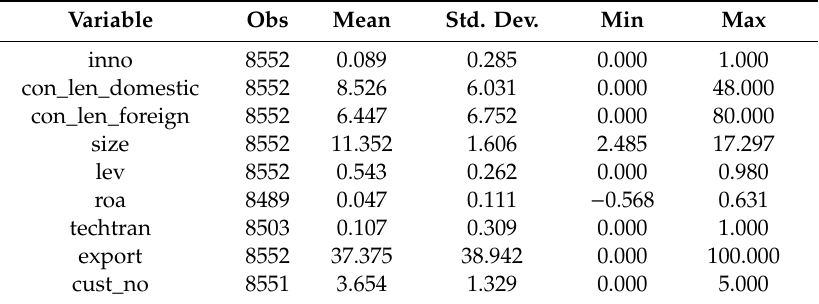
Table 1. Descriptive statistics.